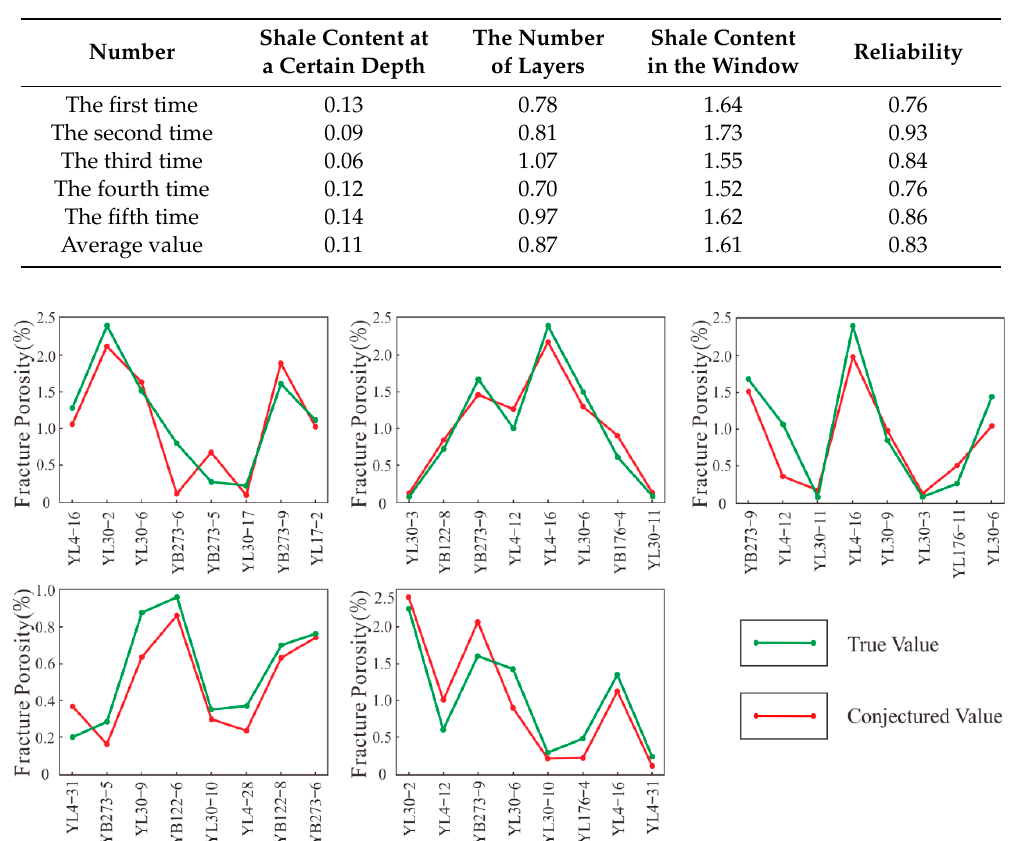
Table 2. Simulation results and reliability of the support vector machine (SVM) model after parameter adjustment.